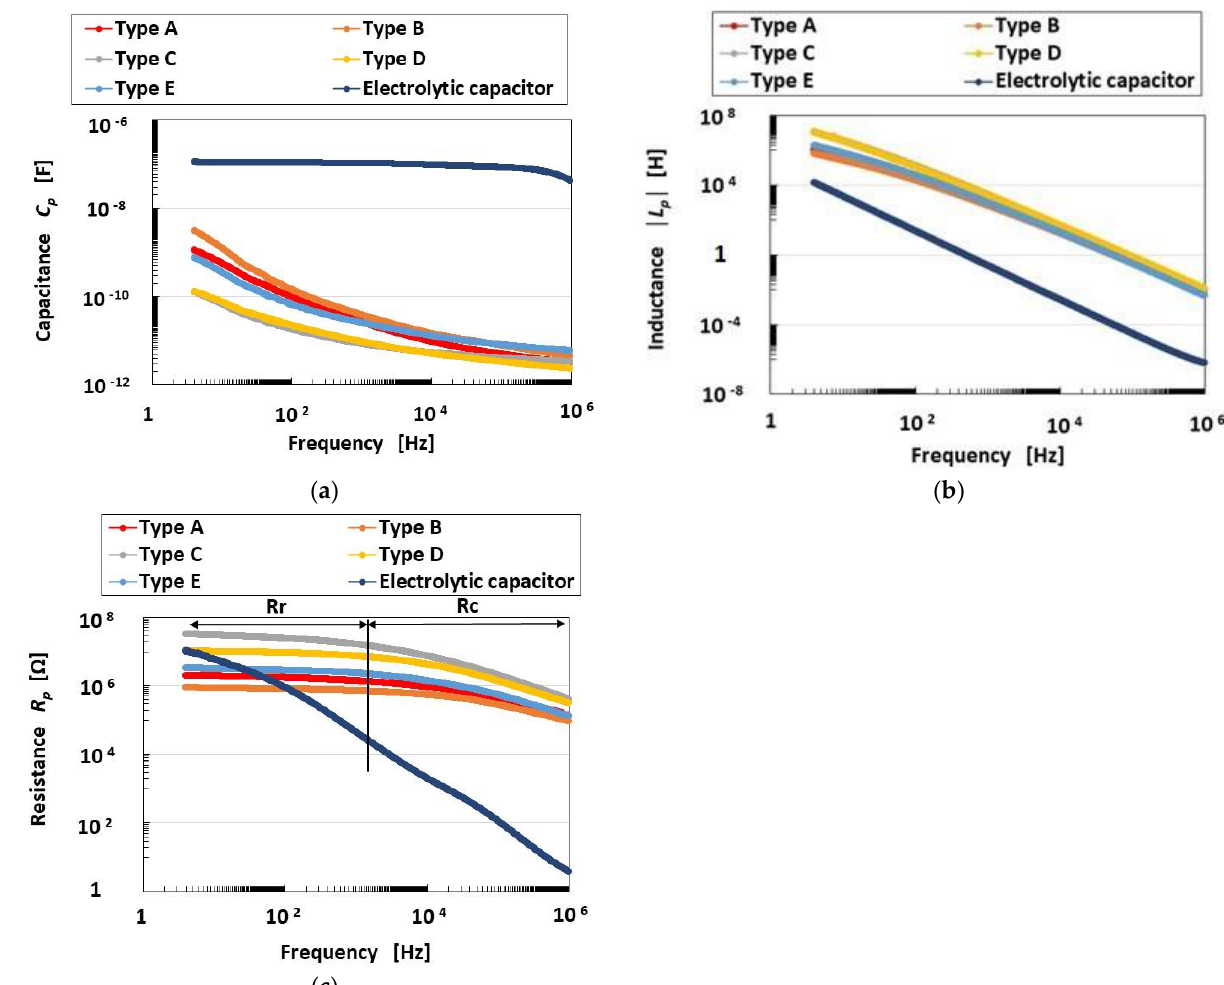
Figure 3. Capacitance, inductance and resistance of the mechanoreceptors: ( a ) capacitance; ( b ) inductance; ( c ) resistance.